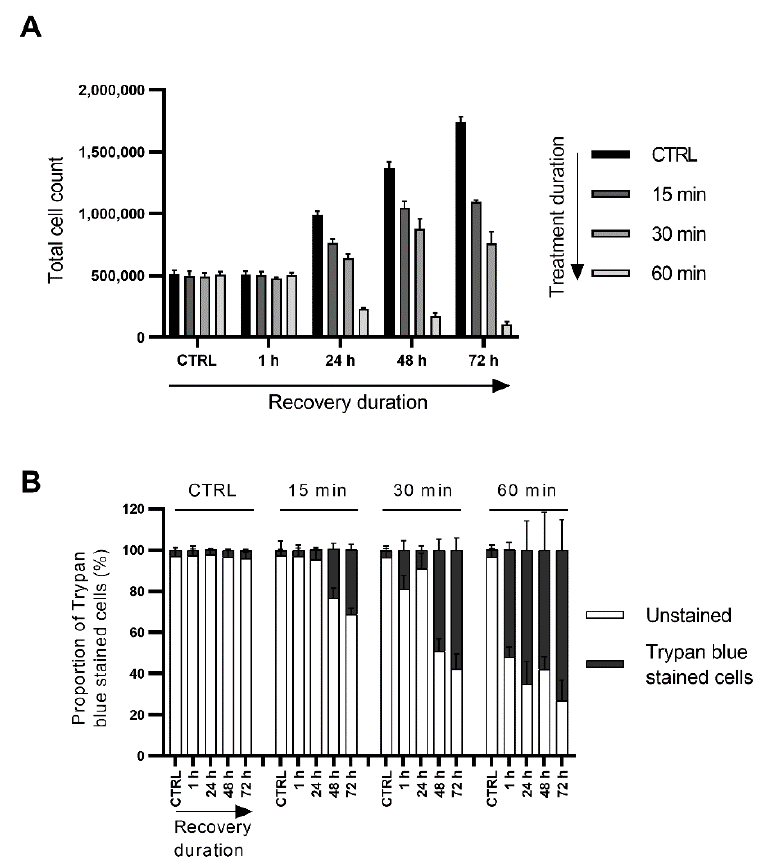
Figure 6. Short exposure to nerolidol reduces cell proliferation and induces both cell death events. ( A ) Total cell count from T24 cells after a short treatment with 100 mg/L of nerolidol (15, 30, or 60 min) followed by a recovery period of 1, 24, 48, and 72 h. ( B ) Cell viability of T24 cells after a short treatment with 100 mg/L of nerolidol (15, 30, or 60 min) followed by a recovery period of 1, 24, 48, and 72 h. Cell viability was assessed by trypan blue staining and presented as the share of stained cells in the total cell count (100%) for each measurement. Stained cells were considered not viable.